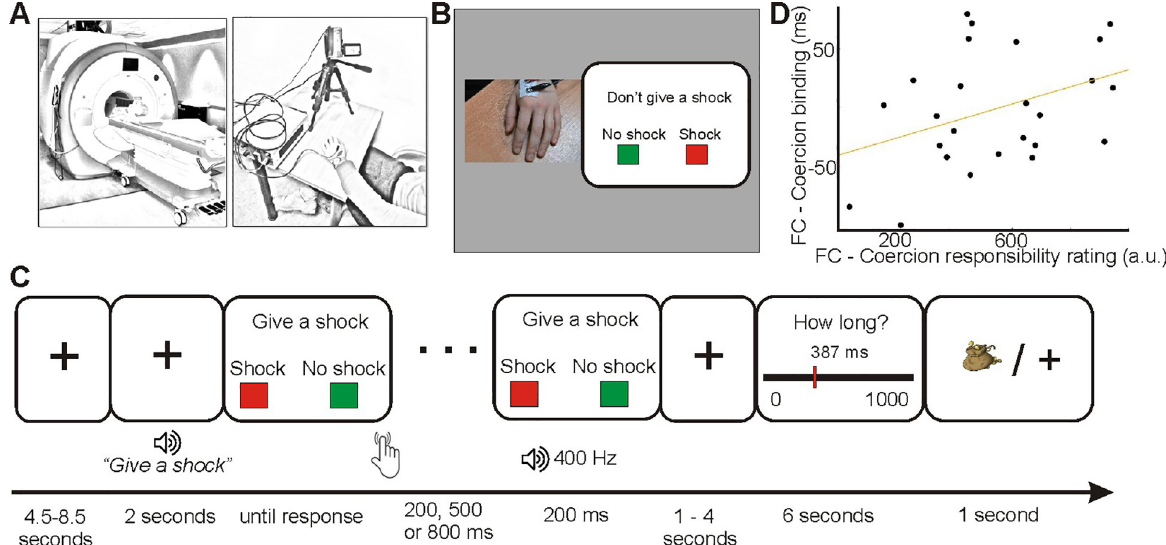
Fig 1. Task setup. A shows the physical setup; one participant (the agent) performed the task inside the MRI, the second (the ‘victim’) in an adjacent room, with a visual ink via camera. B shows the visual presentation inside the MRI: on the left, a live camera feed of the recipient’s hand was shown; on the right, task stimuli were presented. C shows the temporal outline of a single trial. D shows the correlation between the coercion effect on binding and the coercion effect on explicit control ratings.